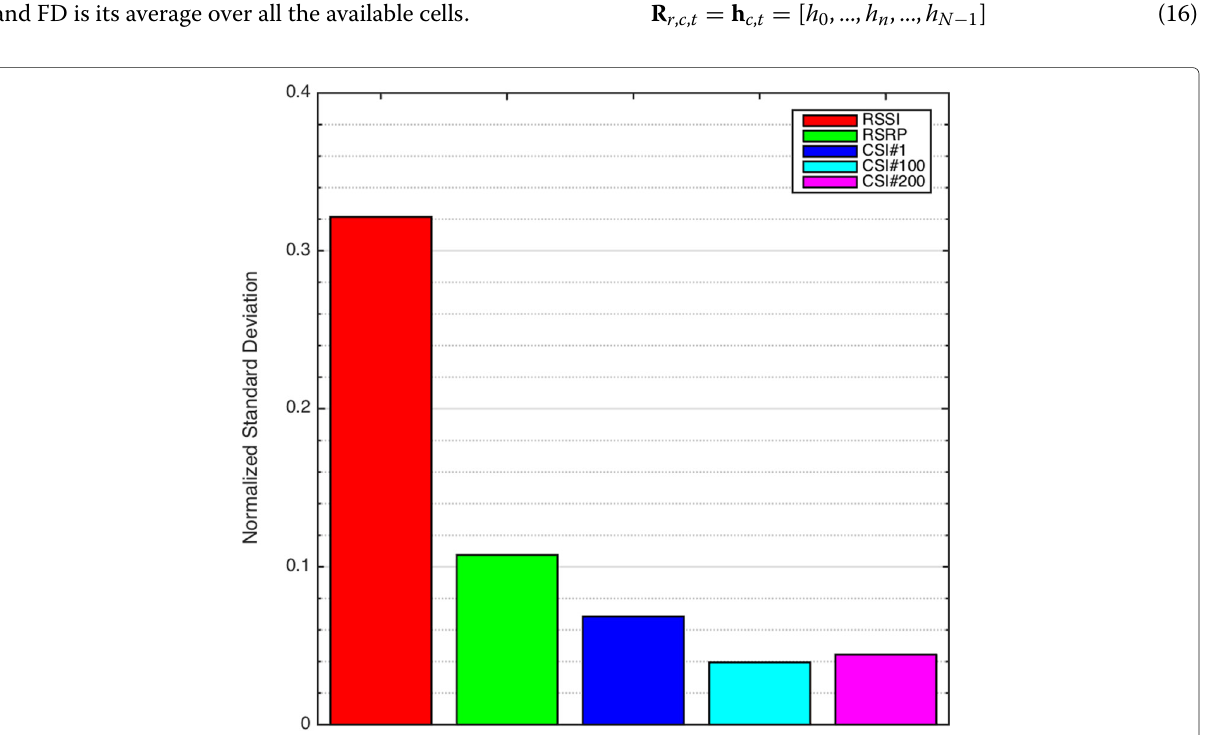
Fig. 3 Temporal stability. RSSI, RSRP, and CSI temporal stability evaluated over a time interval of 30